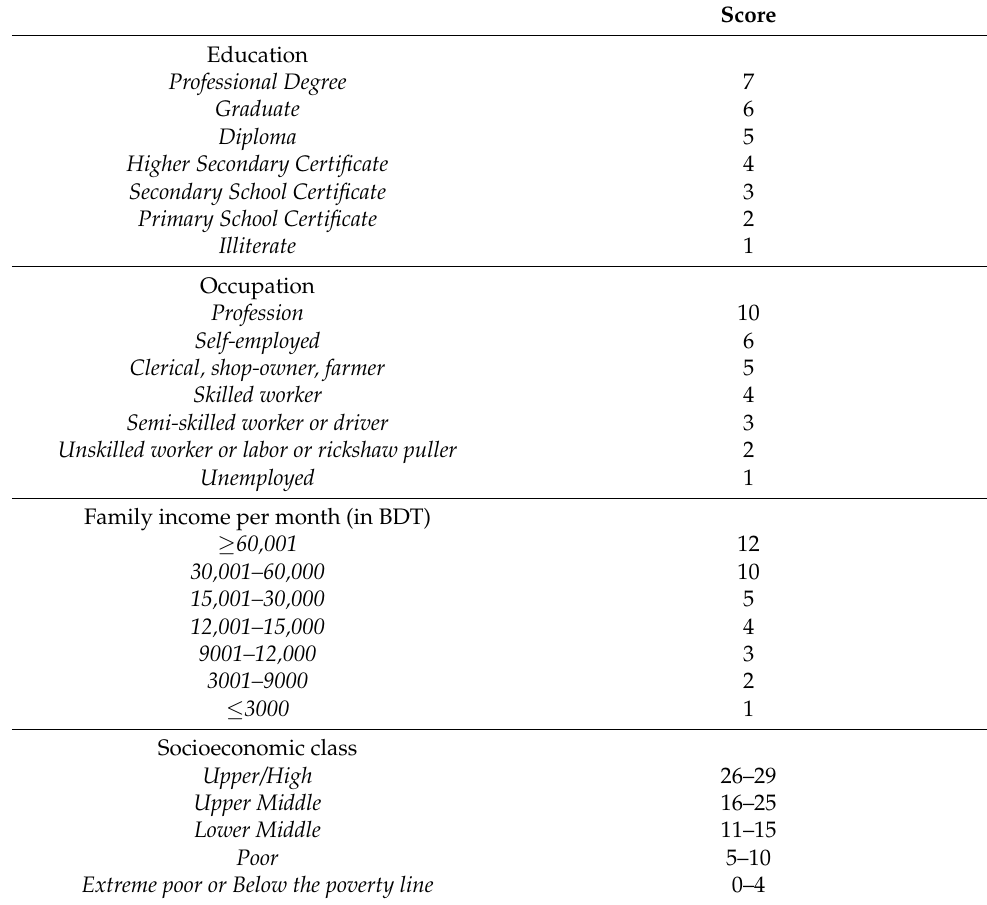
Table 1. Modified Kuppuswamy’s Socioeconomic Scale